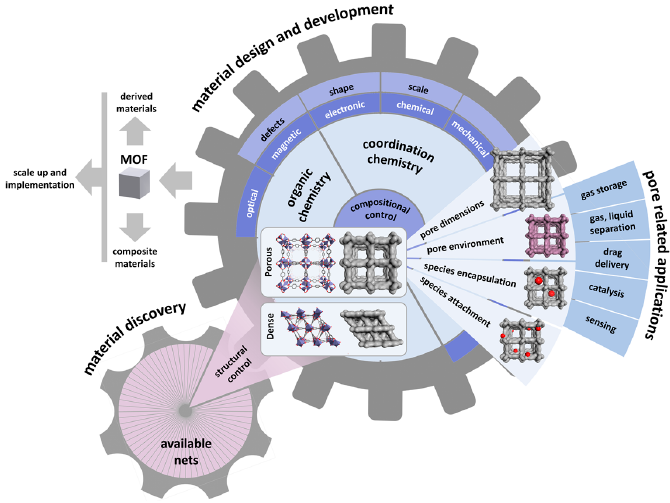
Figure 1. Landscape for metal–organic framework (MOF) research areas, from discovery and design to applications.